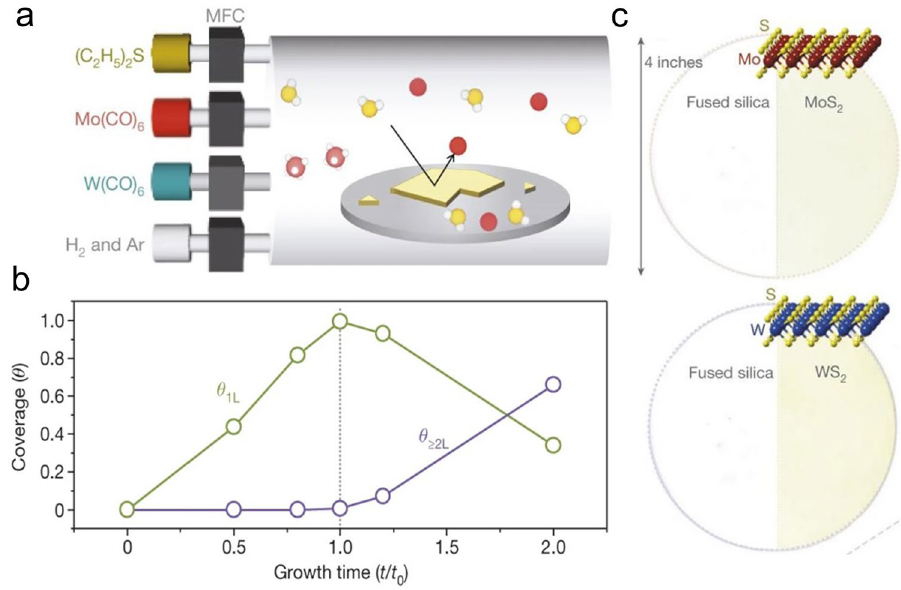
Fig. 3 Growth the MoS 2 , WS 2 by using MOCVD technology. a Diagram of the MOCVD system, b the coverage as the function of growth time, c the optical image of the 4-inch MoS 2 , WS 2 [47], Copyright 2015, Springer